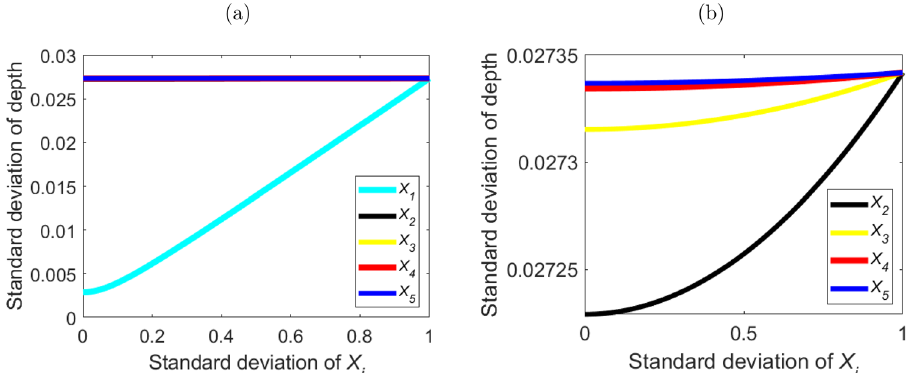
Fig. 3 Standard deviation plots with melt pool depth deviation σ Y on the Y-axis, and standard deviation of main effect X i on the X-axis. a All factor deviations, ( σ P Table 1. Regression output for fi ve MLR models formed by manual selection of variables. Terms Signi fi cant Factors at α =